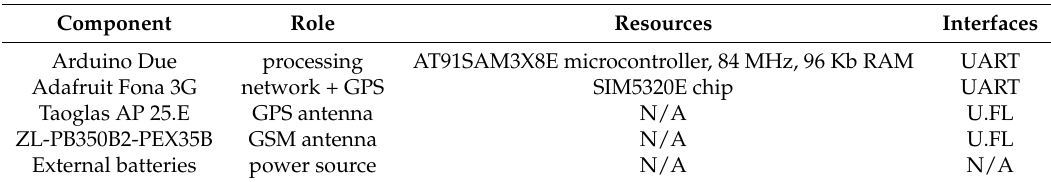
Table 1. System components.